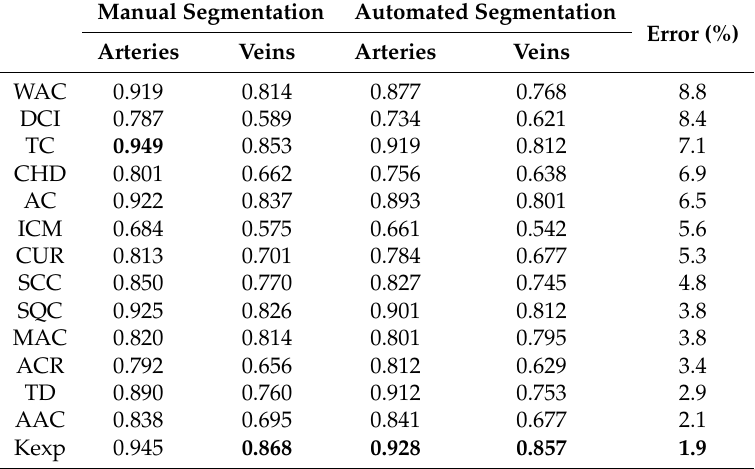
Table 3. Spearman Correlation scores of tortuosity metrics for retinal vessels with manual and automated